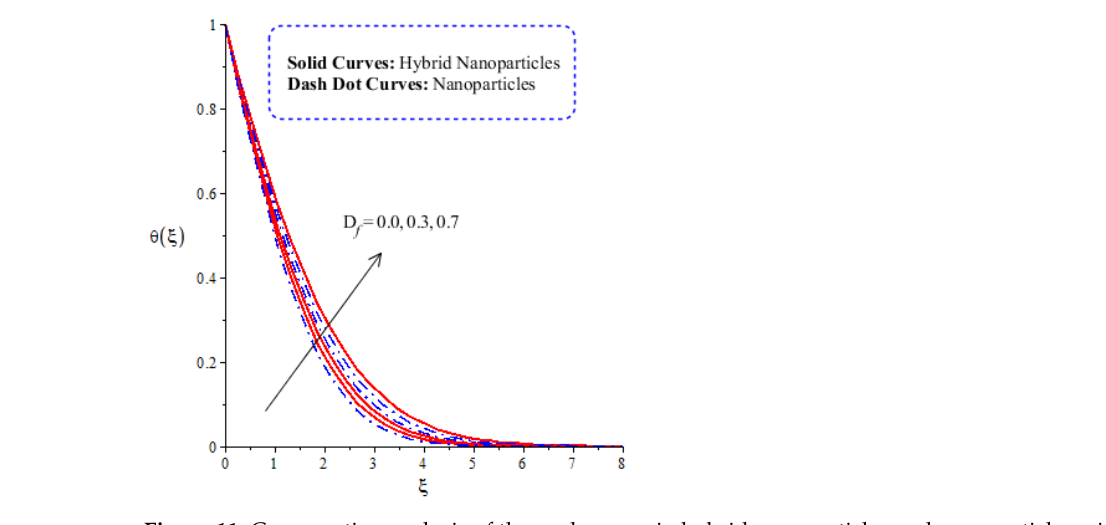
Figure 11. Comparative analysis of thermal energy in hybrid nanoparticles and nanoparticles with changes in D f .